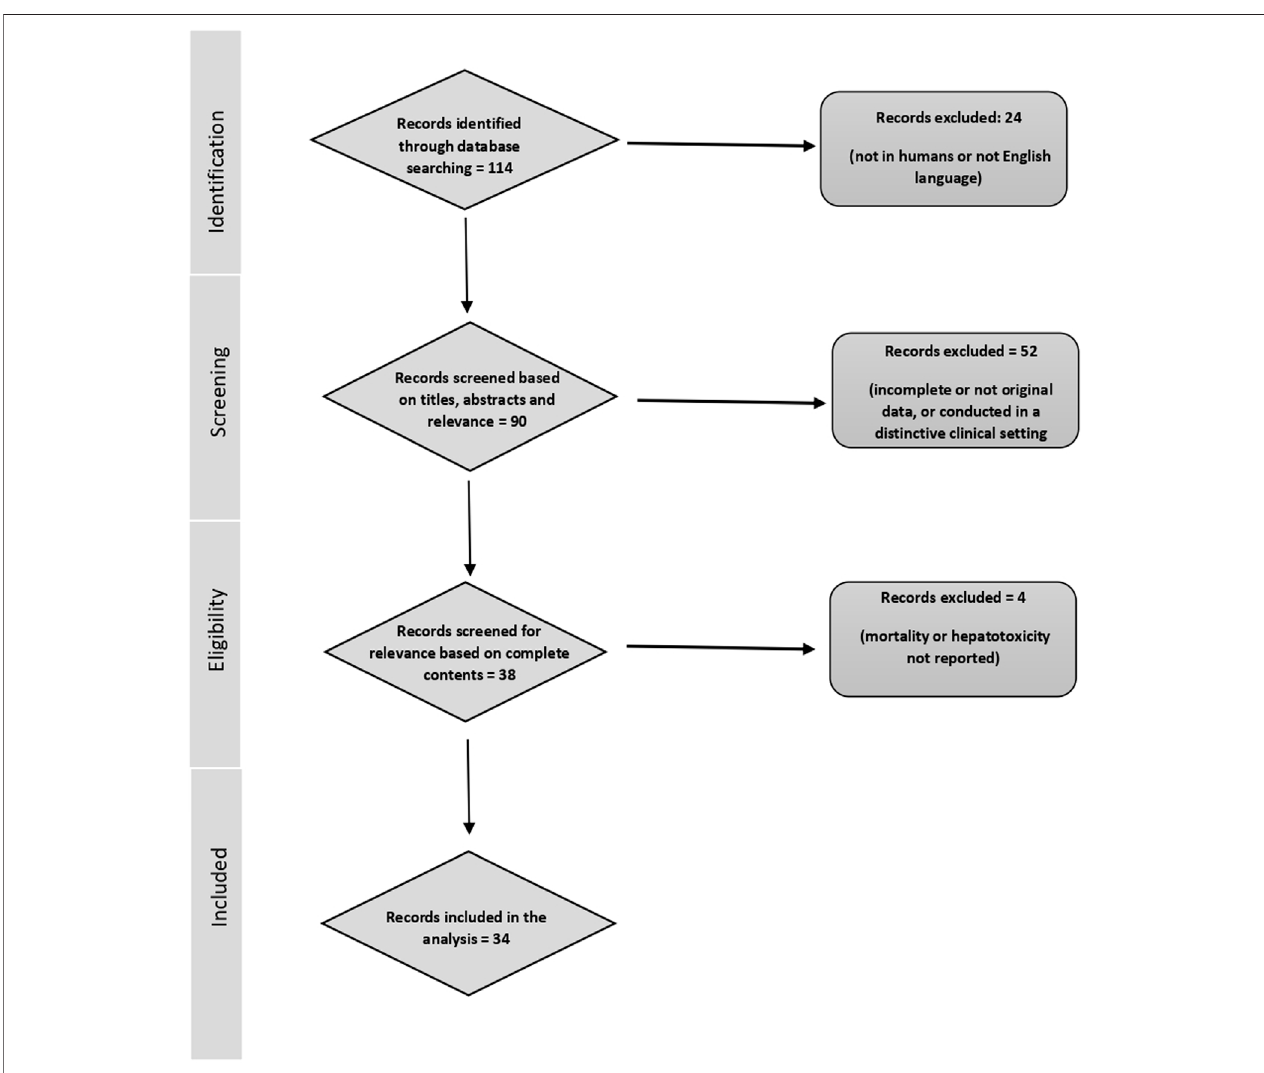
FIGURE 1 | Flow diagram of the report selection of the current